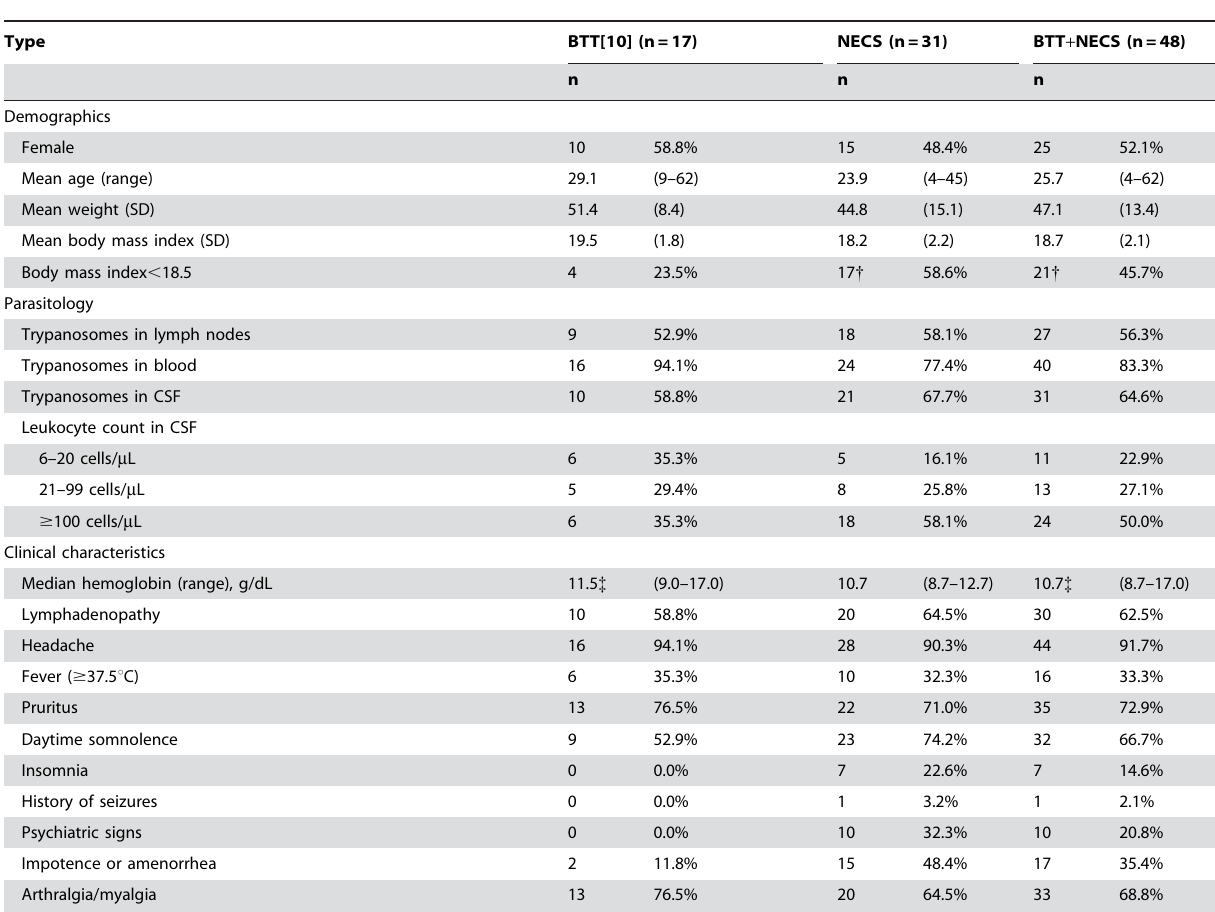
Table 1. Baseline